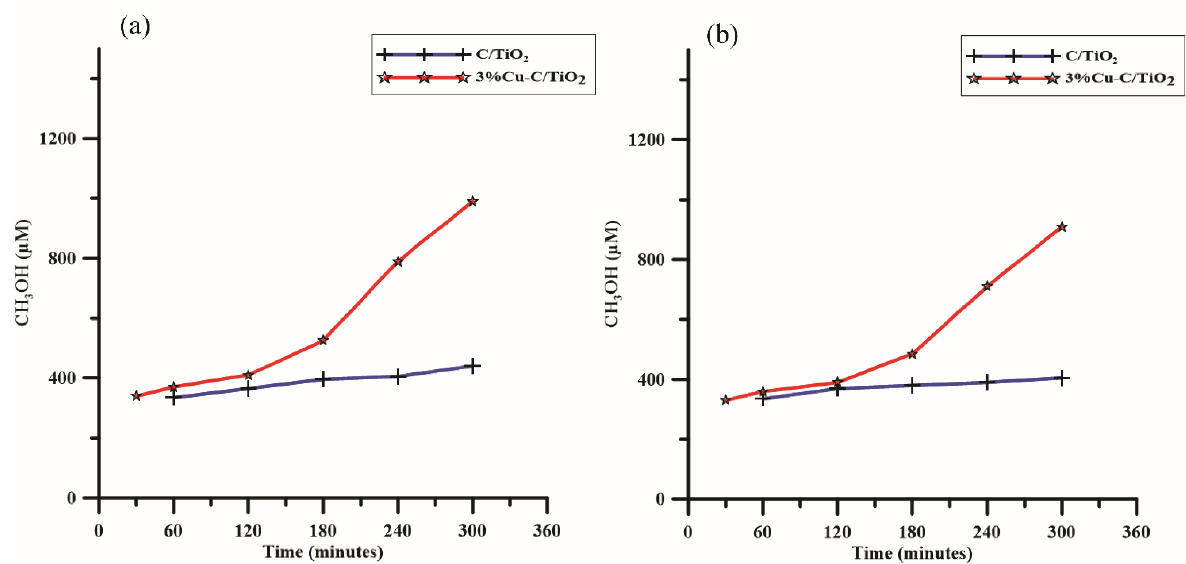
OH under sunlight (a); PSW-1, (b); OH under sunlight 3 3 (a); PSW-1, (b); PSW-2